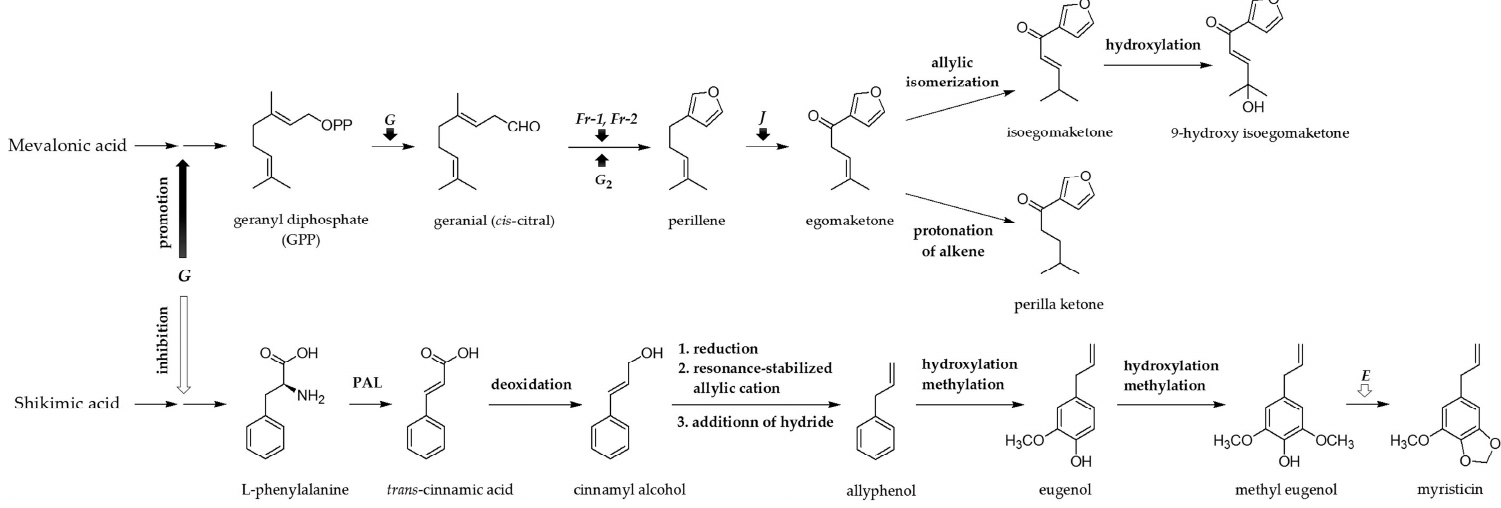
Figure 6. Proposed biosynthetic pathway for four components found in PFCA and PFC [28–32].